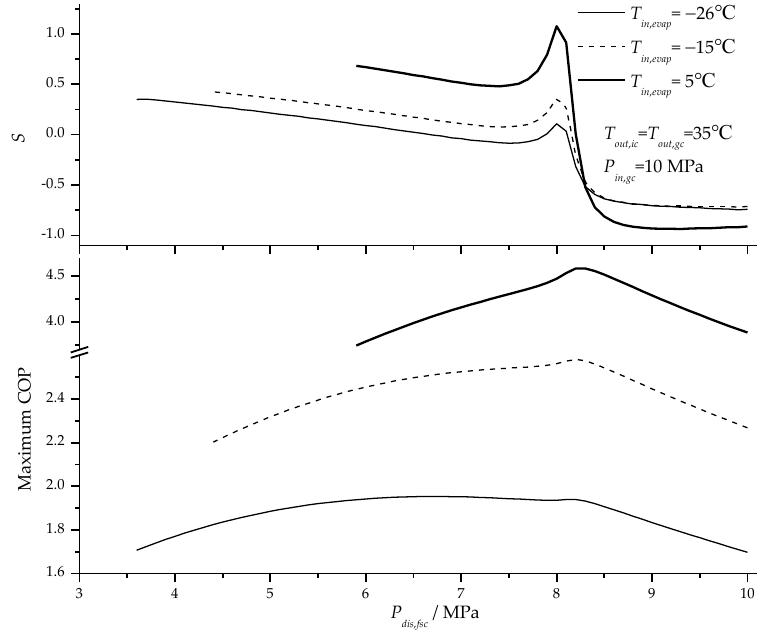
Figure 10. Sensitivity of COP to inter-stage pressure at various evaporator inlet temperatures.